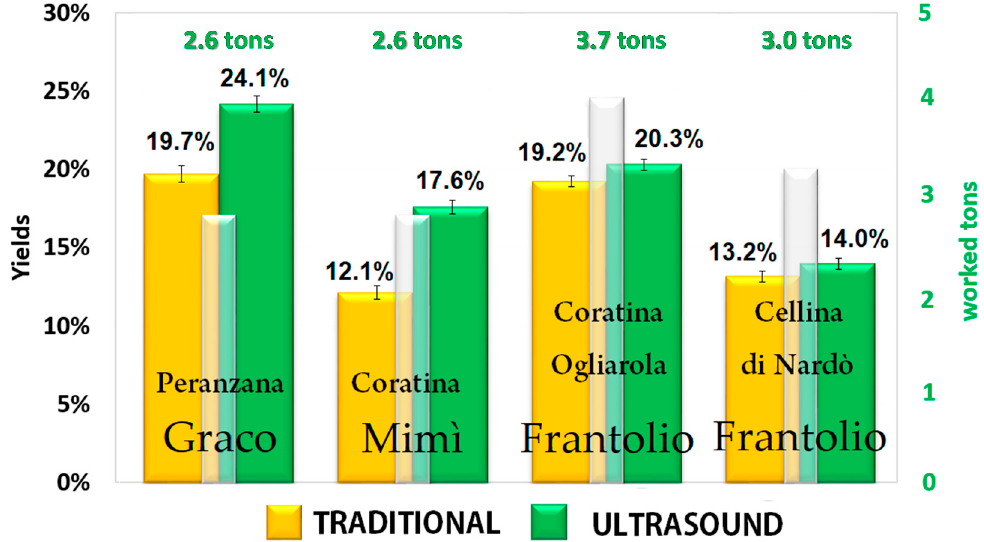
Figure 2. Mean oil yields obtained in the di ff erent oil mills, according to Table 1. The white bars indicate the tons of milled olives; the yellow and green bars indicate the oil yields obtained with and without the use of the sono-heat-exchanger (SHE), respectively.